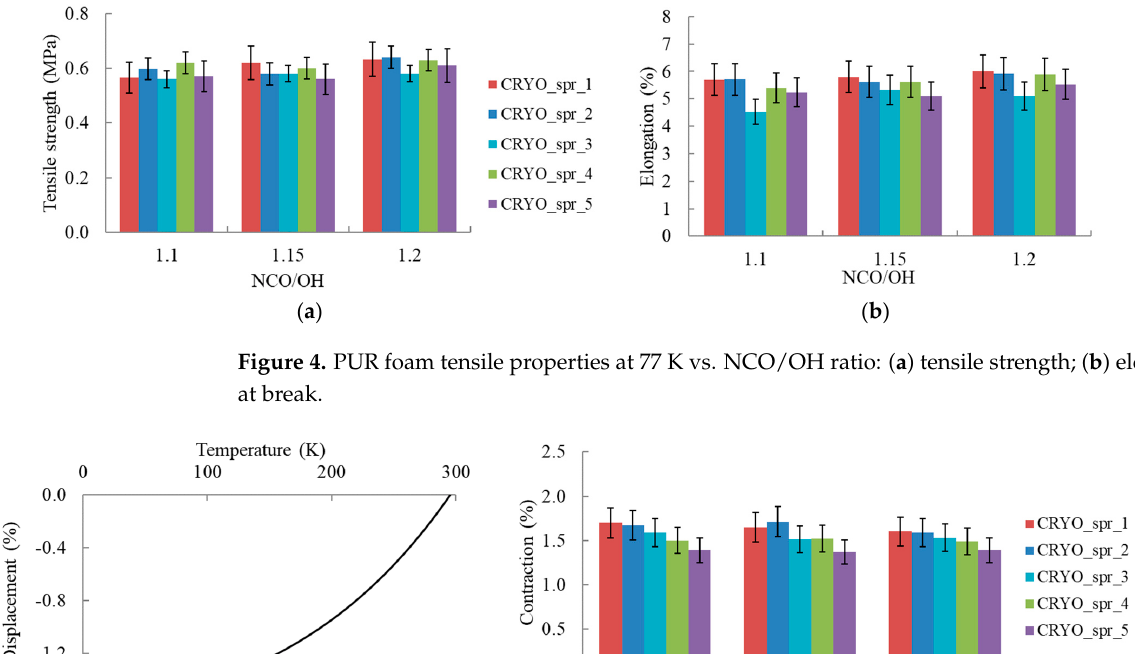
Figure 6. Safety coe ffi cient of PUR foams at 77 K vs. NCO/OH ratio.